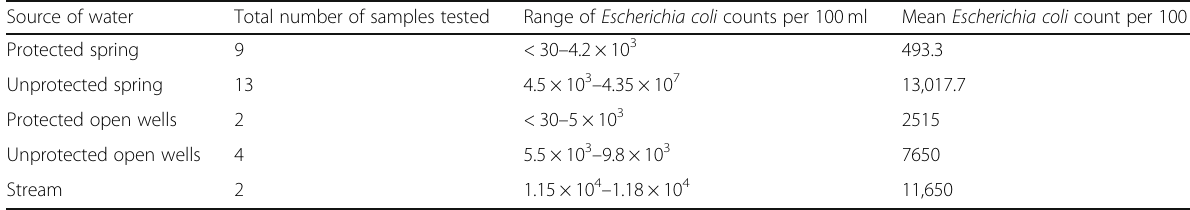
Table 2 Occurrence of Escherichia coli in drinking water for humans Source of